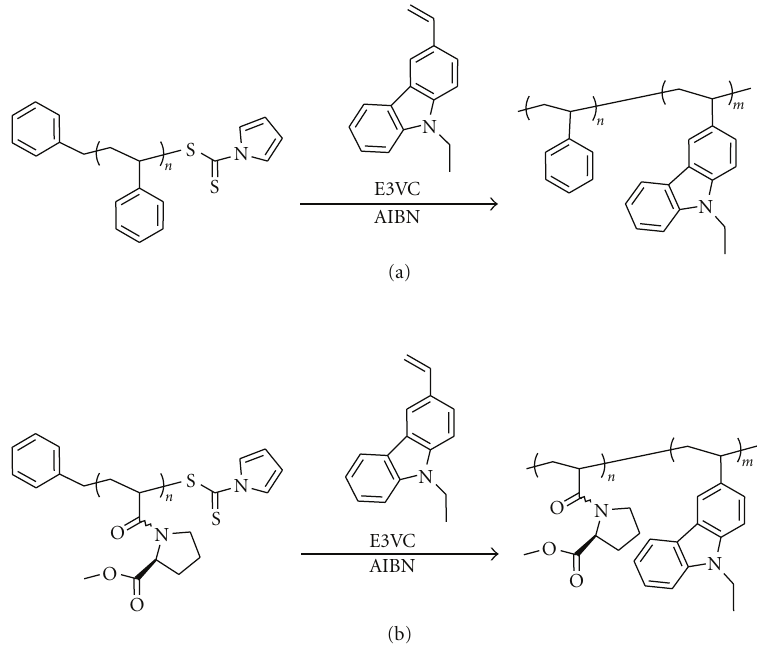
Scheme 7: Synthesis of block copolymers by RAFT polymerization of